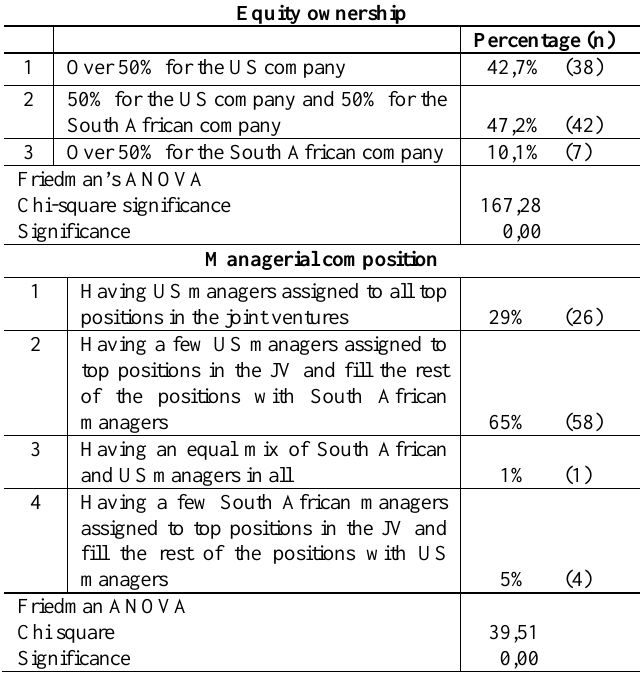
Table 4: Equity and managerial control (N=89)